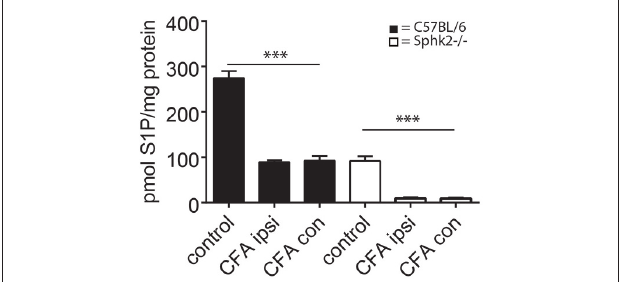
FIGURE 7 | S1P content of ipsi- and contralateral SC in response to CPI induced by CFA in C57BL/6 and Sphk2 − / − mice. Analysis of the amount of S1P in C57BL/6 and Sphk-deficient mice at 7 days post-CFA injection into the hindpaw. The amount of S1P was substantially reduced in ispi- and contralateral SCs from C57BL/6 and Sphk2 − / − mice in comparison to untreated controls (control, n = 5, ispi- and contralateral SC n = 4, one-way ANOVA, Bonferroni’s post hoc test, ∗∗∗ p <